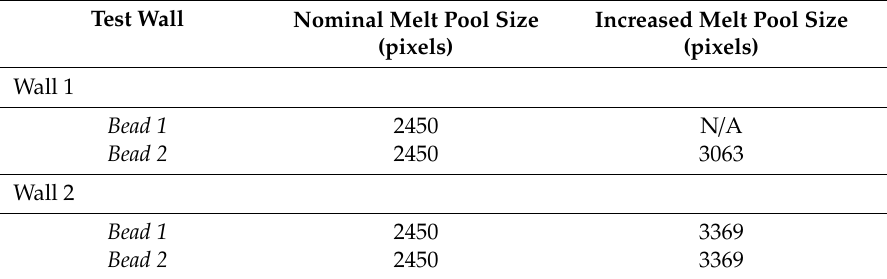
Table 3. Test wall melt pool size